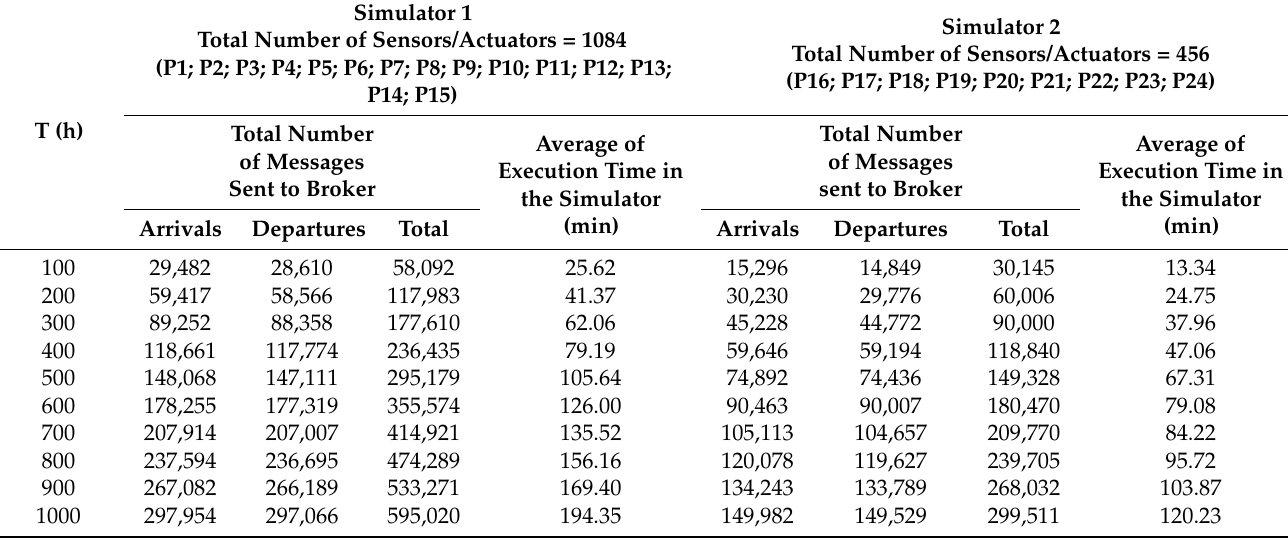
Figure 26. Modular and hierarchical distribution to model an IoT parking system for the north of Madrid. Table 14. Simulation of T hours of operation of parking lots in the north of